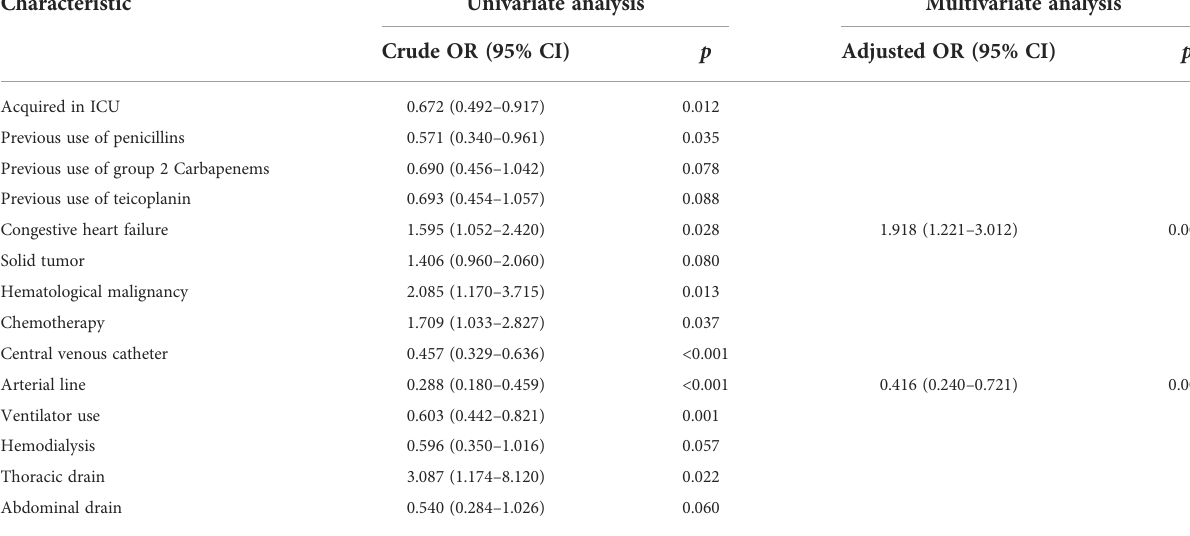
TABLE 4 Logistic regression analysis of predictors for patients infected with bio fi lm-forming Acinetobacter baumannii